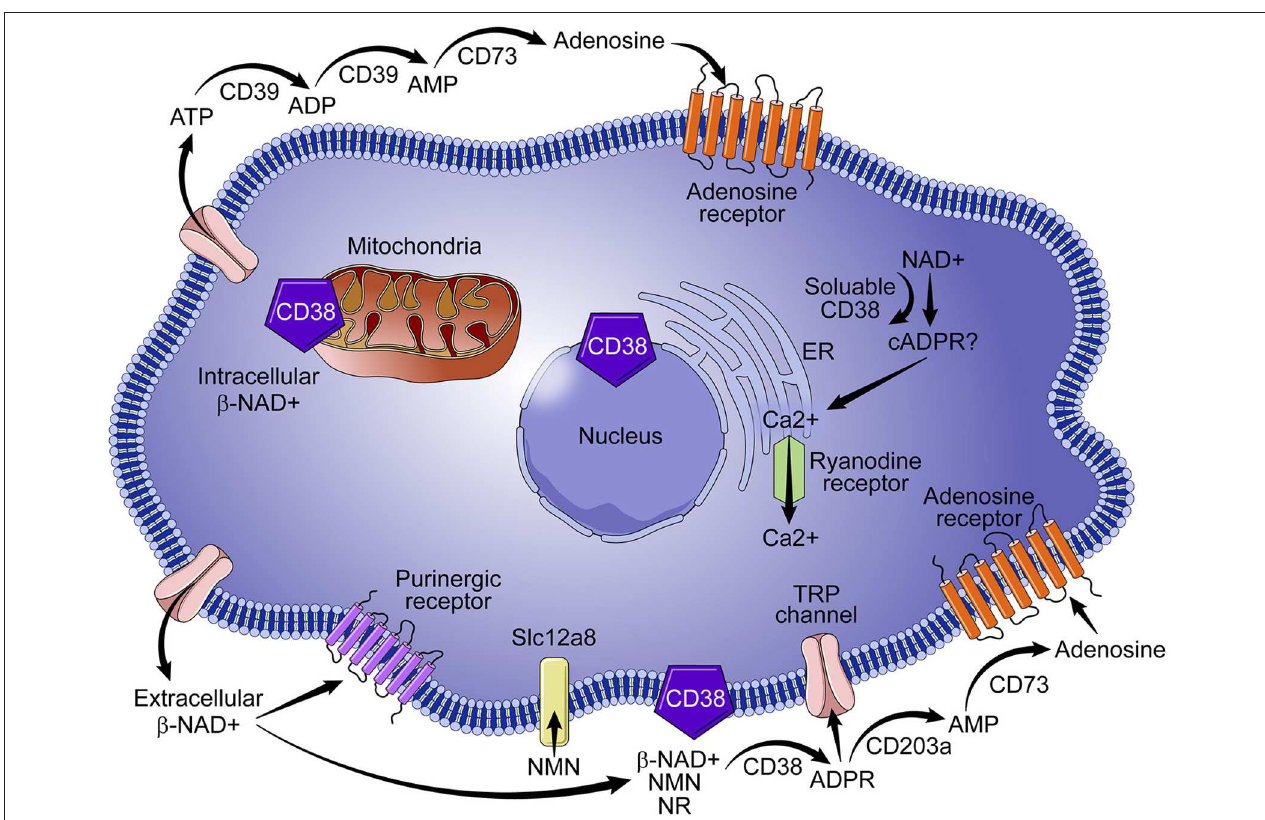
FIGURE 1 | Role of CD38 in NAD + metabolism . CD38 is predominantly expressed on immune cells and metabolizes nicotinamide nucleotides (NAD + and NMN) to ADPR and cADPR, which results in the mobilization of calcium. Although intracellular CD38 is present in the cytoplasm and in the membranes of organelles, a vast majority of CD38 activity is extracellular, which results in degradation of NAD + precursors (e. g., NMN) necessary for NAD + synthesis. Extracellular activity of CD38 has wide ranging implications for NAD + homeostasis in the context of infection, metabolic dysfunction, aging, and tumor